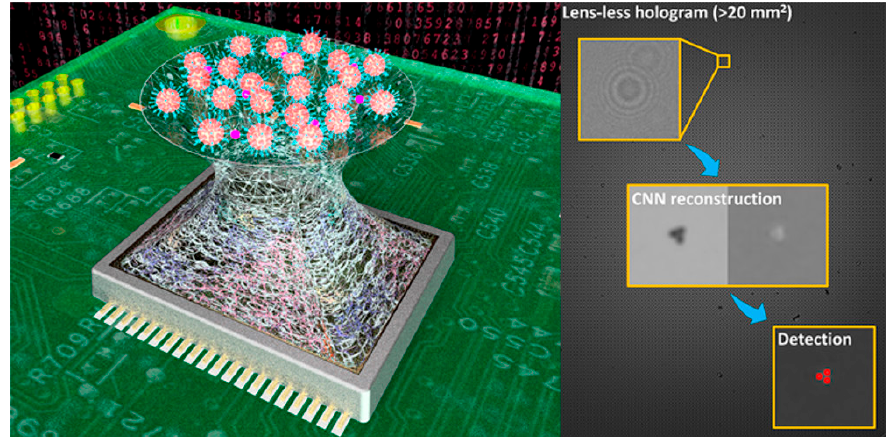
Figure 9. Lensless hologram reconstruction via CNN for particle aggregation detection. Reprinted with permission from [55] without modification. Copyright 2019 American Chemical Society.